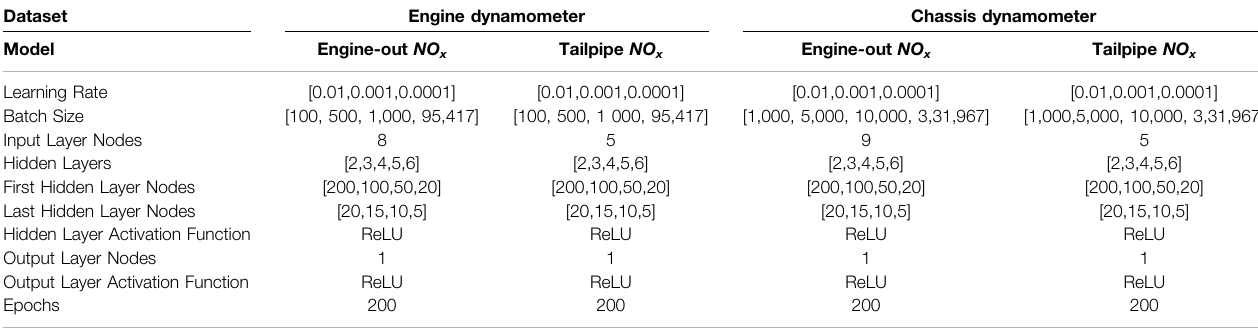
TABLE 2 | Ranges of hyperparameters explored for different models (Engine Dynamometer and Chassis Dynamometer).